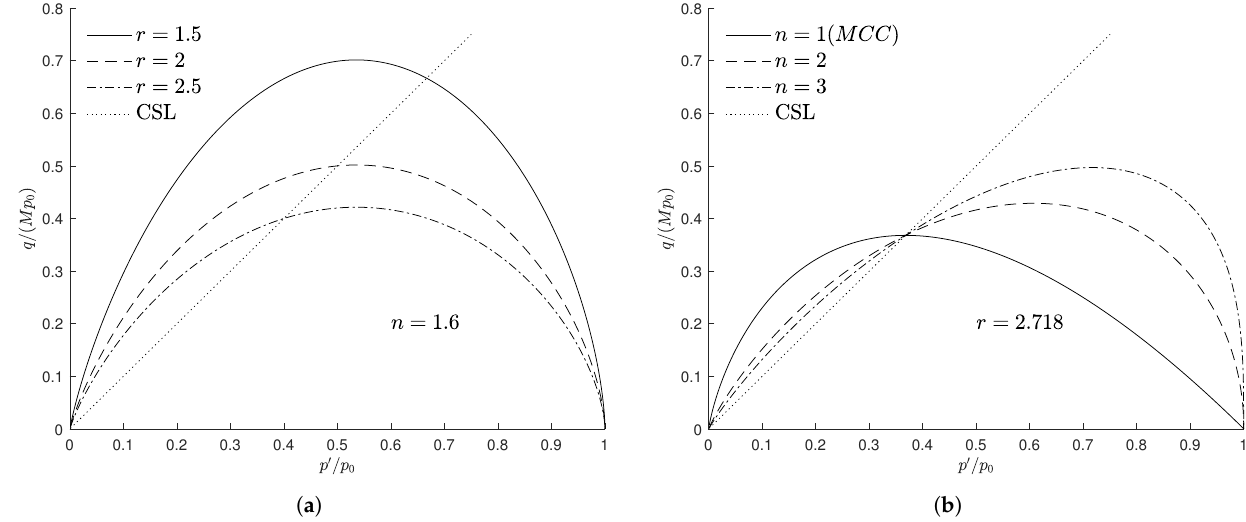
Figure 2. Influence of ( a ) parameter r and ( b ) parameter n on the bounding surface. A non-associated flow rule is assumed here and the plastic potential, in agreement with [34], is expressed